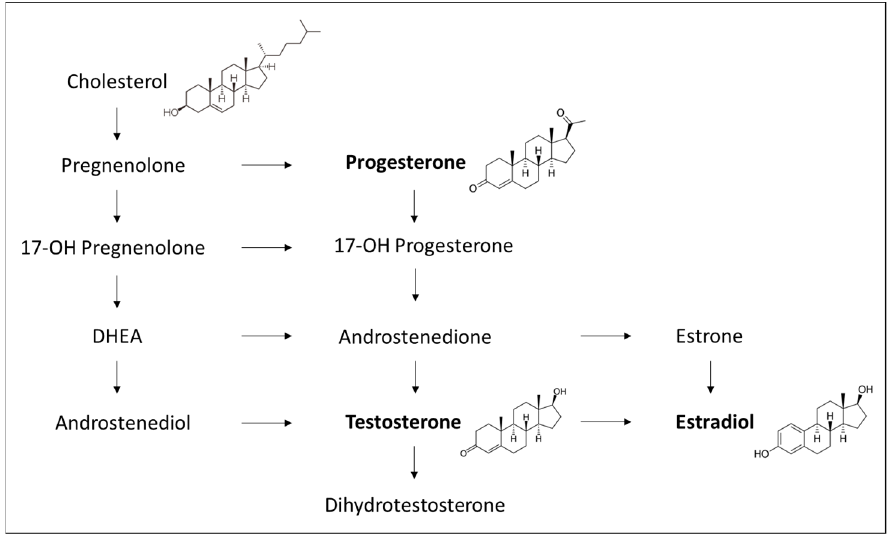
Figure 1. Outline of sex hormone synthesis (modified from [112,126–129]). Production of sex steroids from other tissues—e.g., adipose tissue, skin fibroblasts, bones, or brain—can contribute significantly to the circulating pool of estrogens